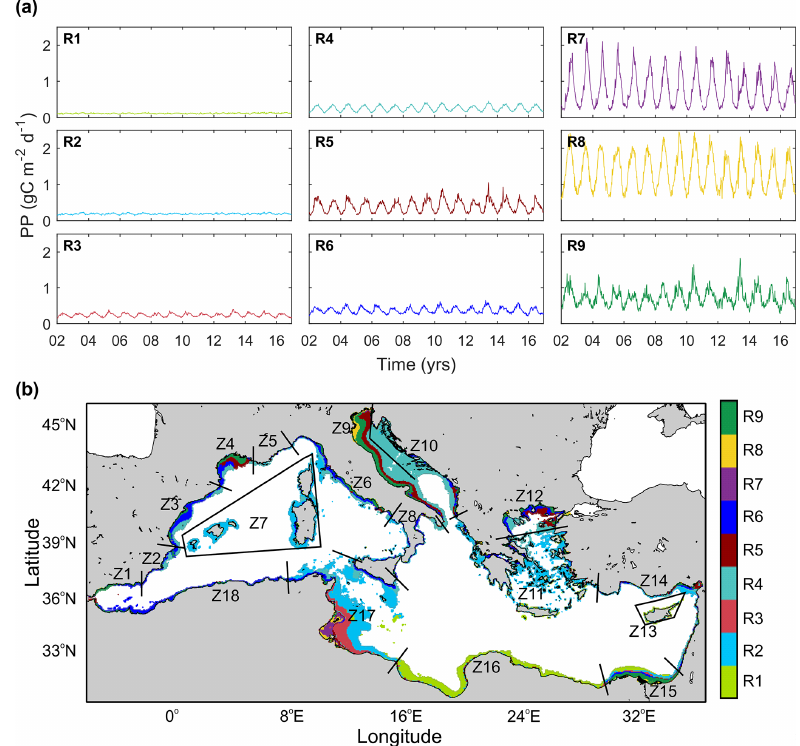
Figure 7. Regionalization of the coastal waters in the Mediterranean Sea based on their temporal patterns of pelagic primary production. (a) Characteristic temporal patterns of PP obtained from SOM classification (R1 to R9) and (b) coastal regions defined from alongshore variations in the SOM – regions (Z1 to Z18).